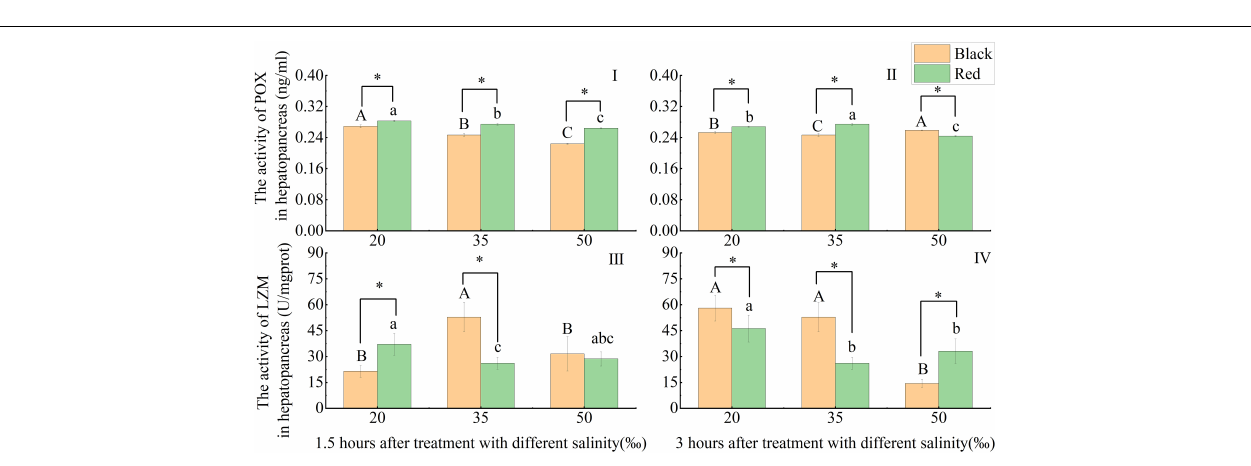
FIGURE 4 | Effects of acute salinity stress on the activities of phenoloxidase (POX) and lysozyme (LZM) in the hepatopancreas of black and red P. fucata ( I: 1.5 h, POX activity. II: 3 h, POX activity. III: 1.5 h, LZM activity. IV: 3 h, LZM activity). The asterisk sign “ ∗ ” indicates that there are significant differences between the different shell colors at the same salinity ( p <